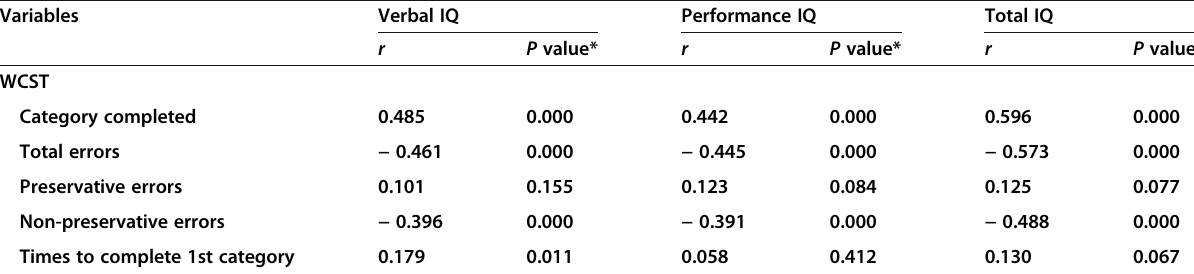
Table 3 Correlation between IQ and executive functions Variables Verbal